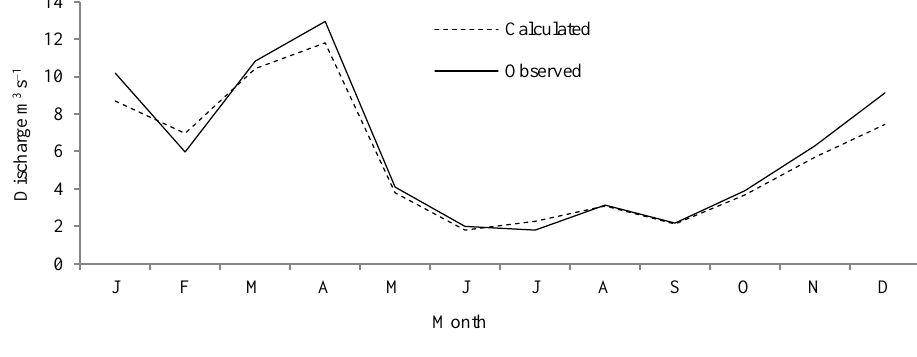
Fig. 5. Observed and calculated average monthly discharge in the outlet of the Berze River during the time period of